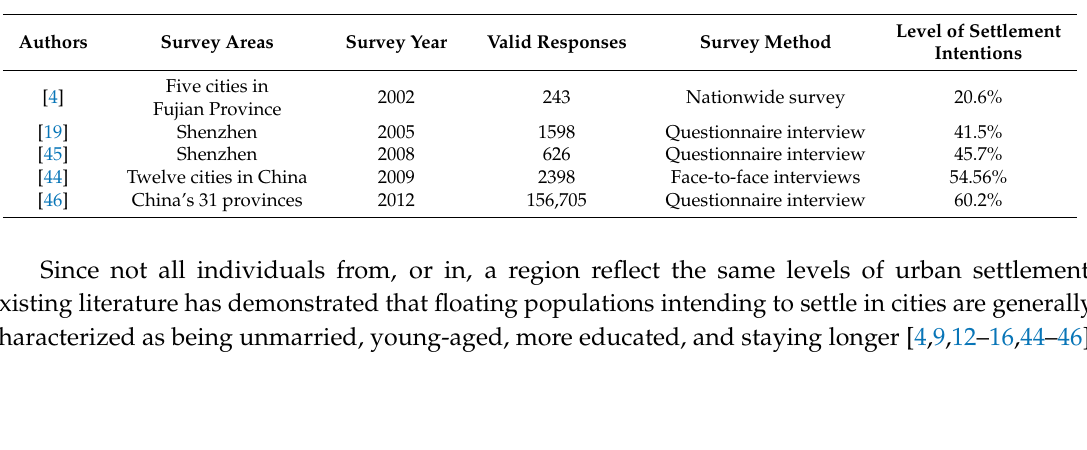
Table 1. Some survey results of the settlement intentions of the floating